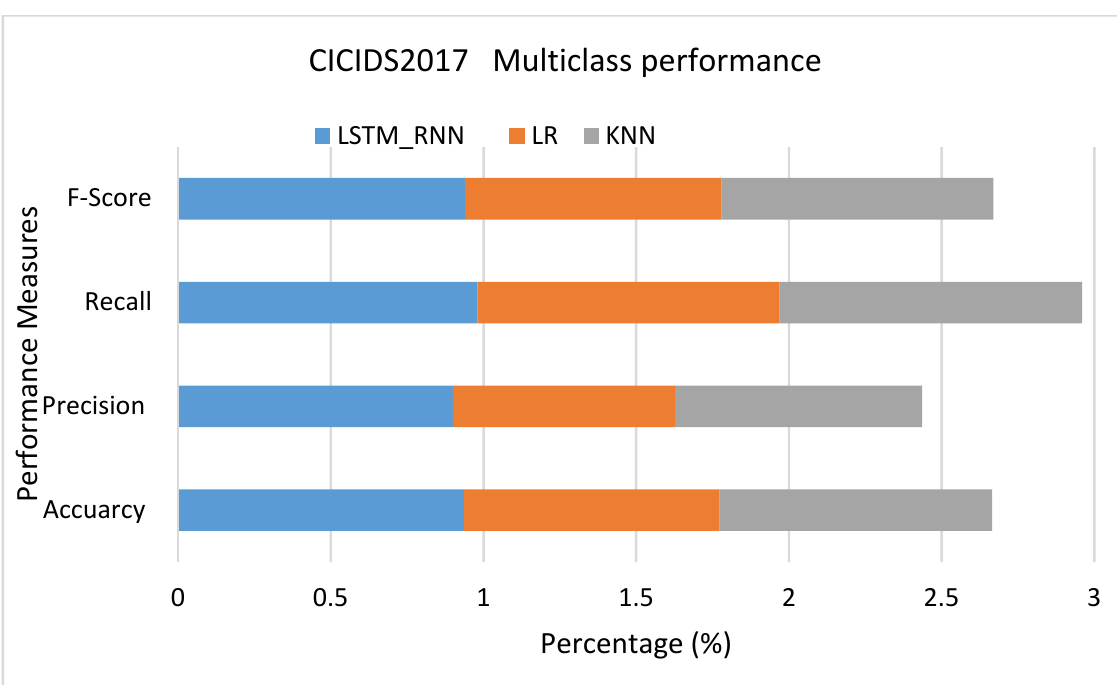
Figure 24. CICIDS2017 Binary classification performance.